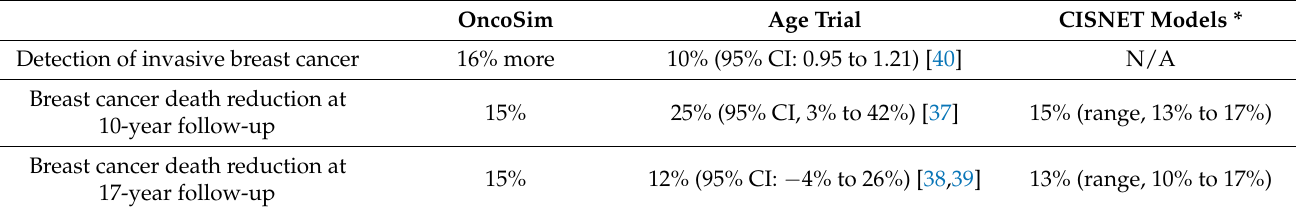
Figure 5. Distribution of breast cancer by stage at diagnosis, females, Canada, 2011–2015, OncoSim- Breast vs. Canadian Cancer Registry. * The Canadian Cancer Registry did not include data from Quebec in 2011–2015 because Quebec switched to a different cancer reporting system after 2010. Table 2. OncoSim’s projections vs. the observed estimates from the UK Age trial and predictions from the CISNET